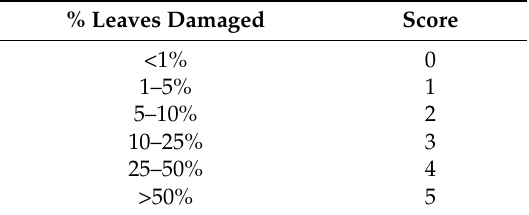
Table 1. Damage scores used for categorizing extent of damage to different plant patches, based on the percentage of leaves showing any signs of damage and placed in to one of six broad